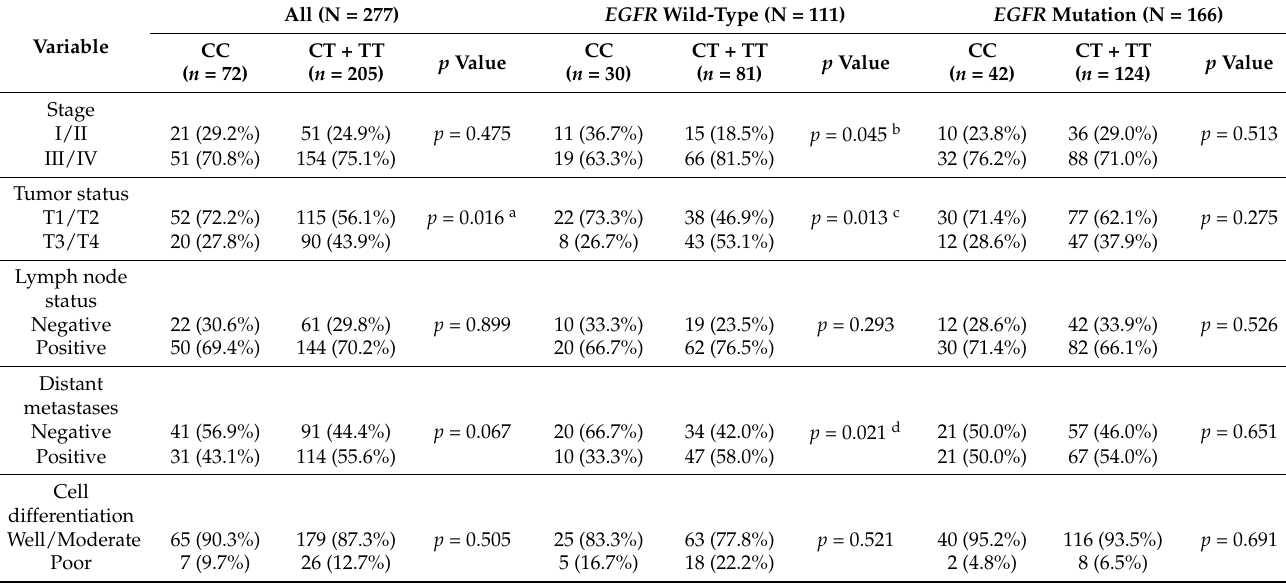
Table 4. Clinicopathologic characteristics of lung adenocarcinoma patients stratified by EGFR status and genotypes at visfatin